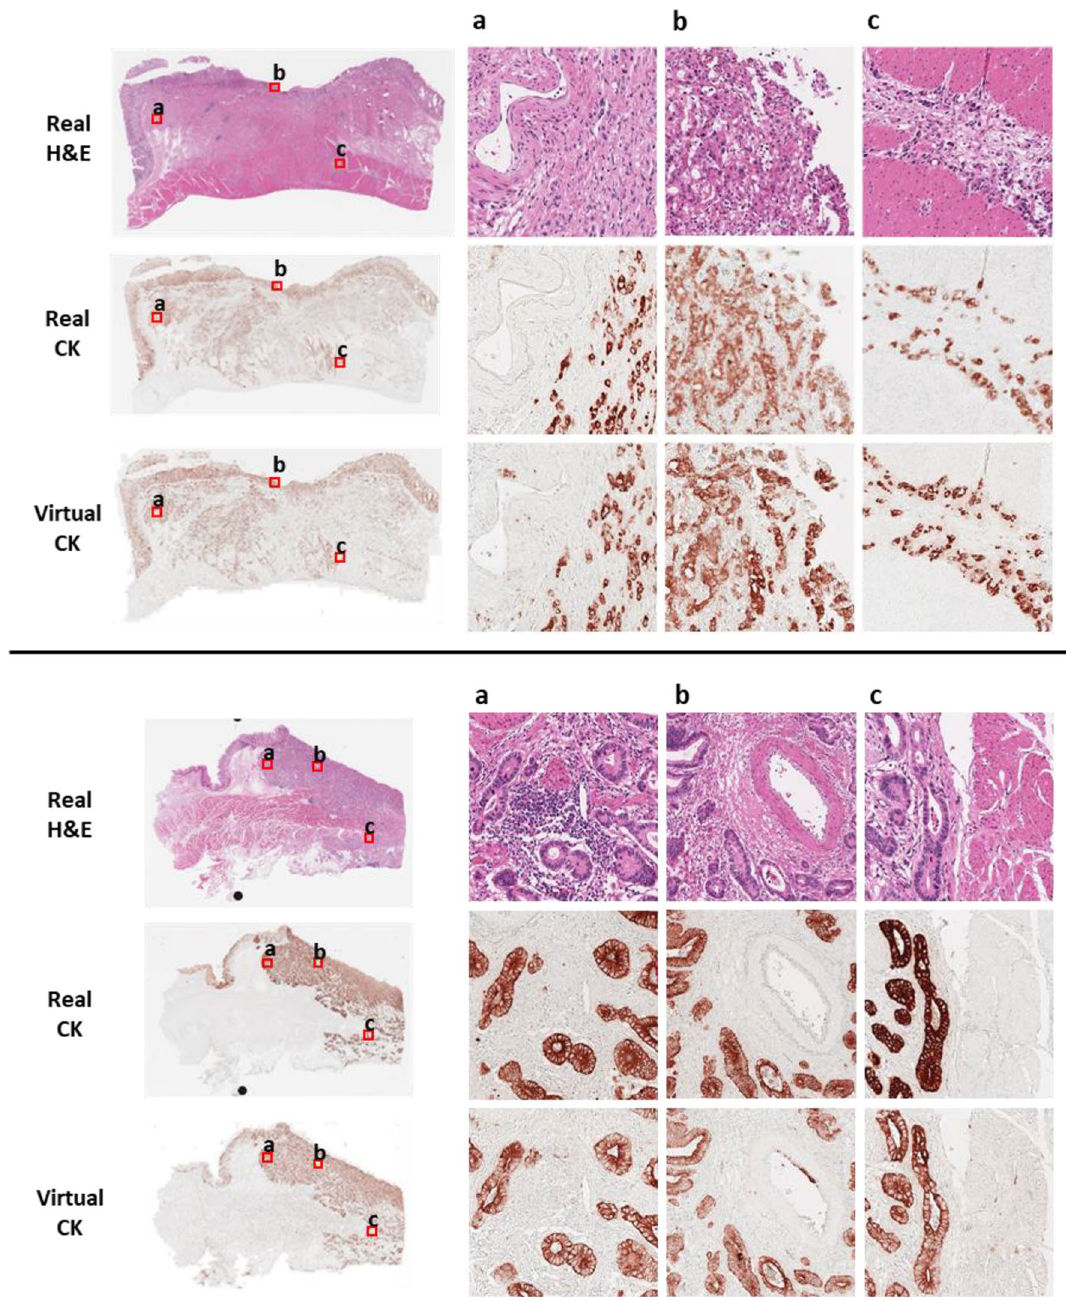
Figure 5. Visual comparison of real hematoxylin and eosin (H&E)- and real cytokeratin (CK)-stained images against virtual CK-stained images at the WSI and patch